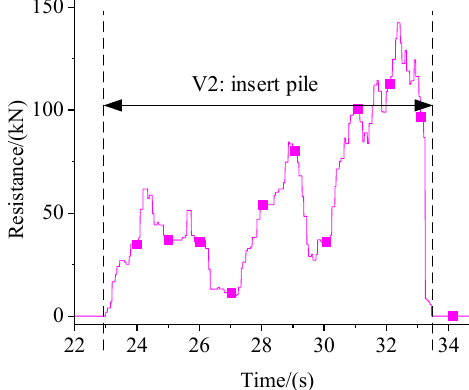
Figure 18. Data of the insertion resistance.